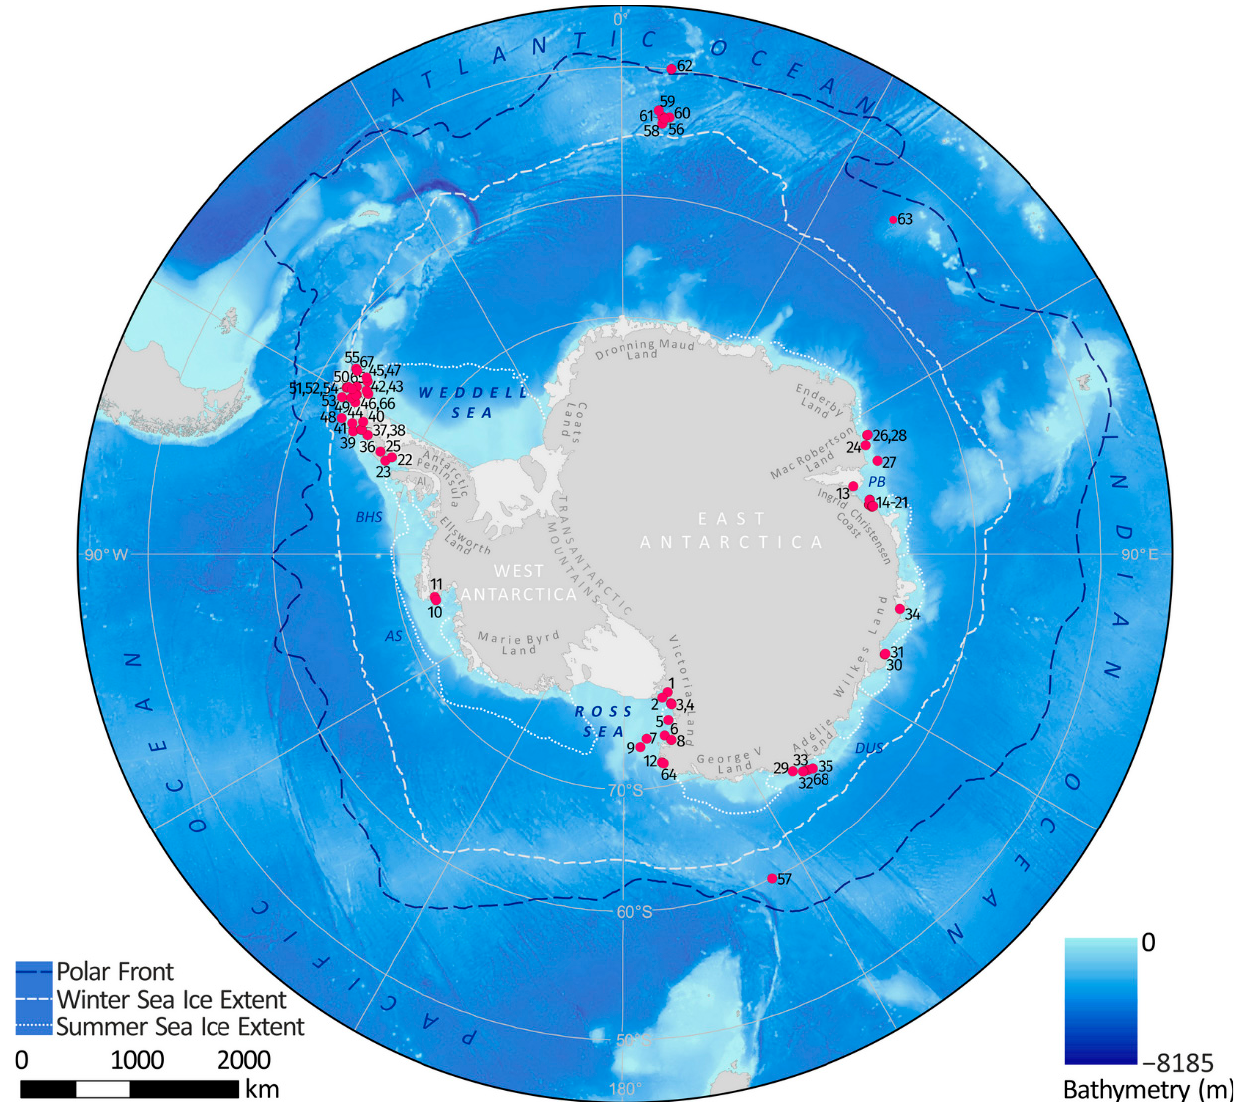
Figure 1. Map showing sites (red-filled circles) of published marine sediment core records with diatom-based sea ice proxies for all or part of the past 2 ka. Sites are numbered corresponding to the map references given in Table 1. AS—Amundsen Sea; BHS—Bellingshausen Sea; DUS—Dumont d’Urville Sea; PB—Prydz Bay. Winter and summer sea ice limits depict the 1981–2010 median September and February sea ice extents (Source: /DATASETS/NOAA/G02135/south/monthly/).